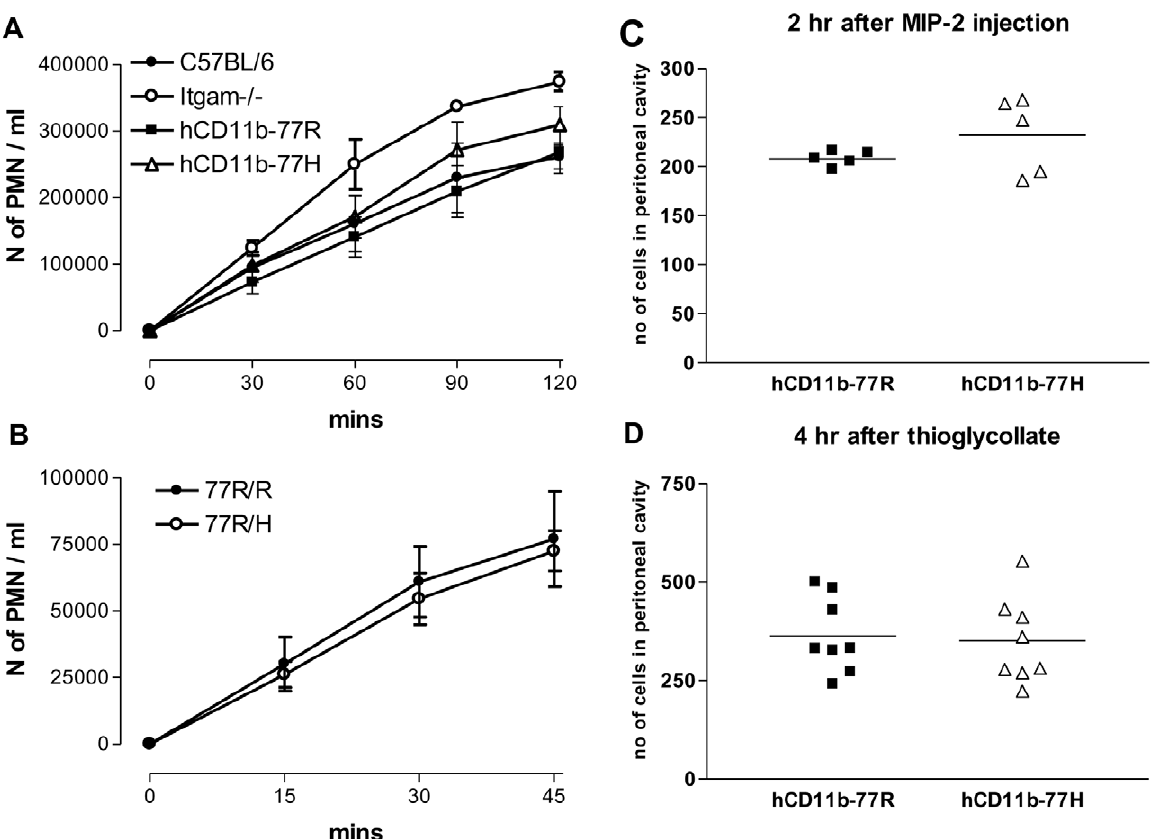
Figure 4. Invitro and invivo PMN migration. (A) Migration of neutrophil cell lines through transwells seeded with mouse endothelial cells. PMNs migrated into the bottom chamber in response to MIP-2 were counted at different time points as indicated. Pooled results from at least 4 independent experiments are presented as mean 6 SEM. Itgam 2 / 2 and wild type C57BL/6 neutrophil cell lines were used as controls. CD11b- deficient PMNs, known to have weaker endothelial interactions, migrated faster than the C57BL/6 and the hCD11b expressing cell lines (p , 0.001 at 60 mns and p , 0.05 at 90 mns). Statistical analysis by Bonferroni’s multiple comparison test. (B) Time course of the migration of freshly isolated human 77R/R or 77R/H neutrophils through a HUVEC layer in response to MIP-2. Pooled results from at least 4 independent experiments are presented as mean 6 SEM. (C, D) In vivo peritoneal migration of hCD11b-77R and hCD11b-77H PMN cells lines following i.p. injection of MIP-2 (C) and thioglycollate (D). The two hCD11b expressing PMN lines were labelled with DDAO or CFSE and adoptive transferred at a 1:1 ratio into C57BL/6 mice. Absolute numbers of labelled PMNs recovered from the peritoneum are shown. Data of one out of at least 3 independent experiments are presented. Bars indicate